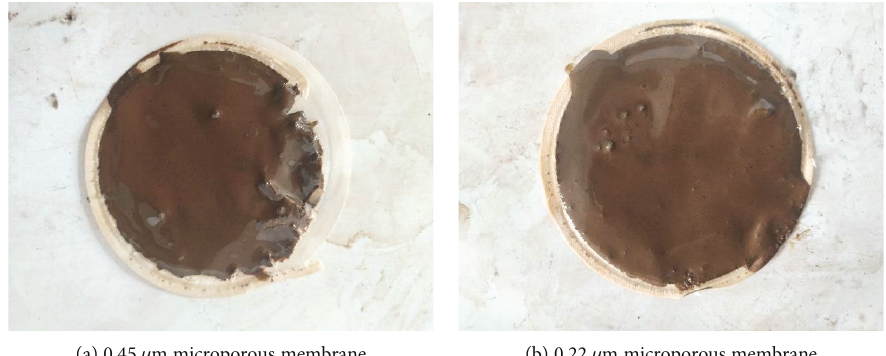
Figure 9: Experimental results of microporous fi lter